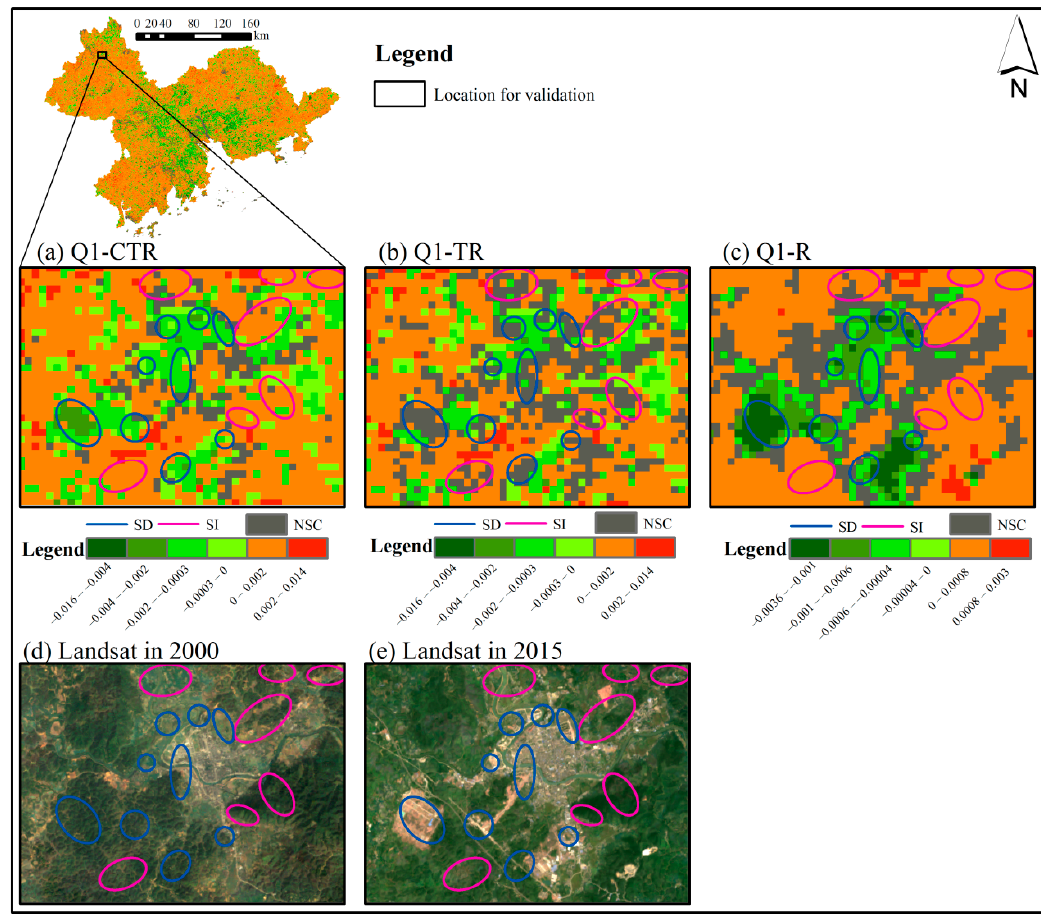
Figure 14. Comparison of Q1-CTR, Q1-TR, Q1-R, and Landsat: ( a ) result of Q1-CTR in location of validation; ( b ) result of Q1-TR in location of validation; ( c ) result of Q1-R in location of validation; ( d ) Landsat image in 2000; and ( e ) Landsat image in 2015; SD indicates significant decrease; SI indicates significant increase; NSC indicates no significant change.